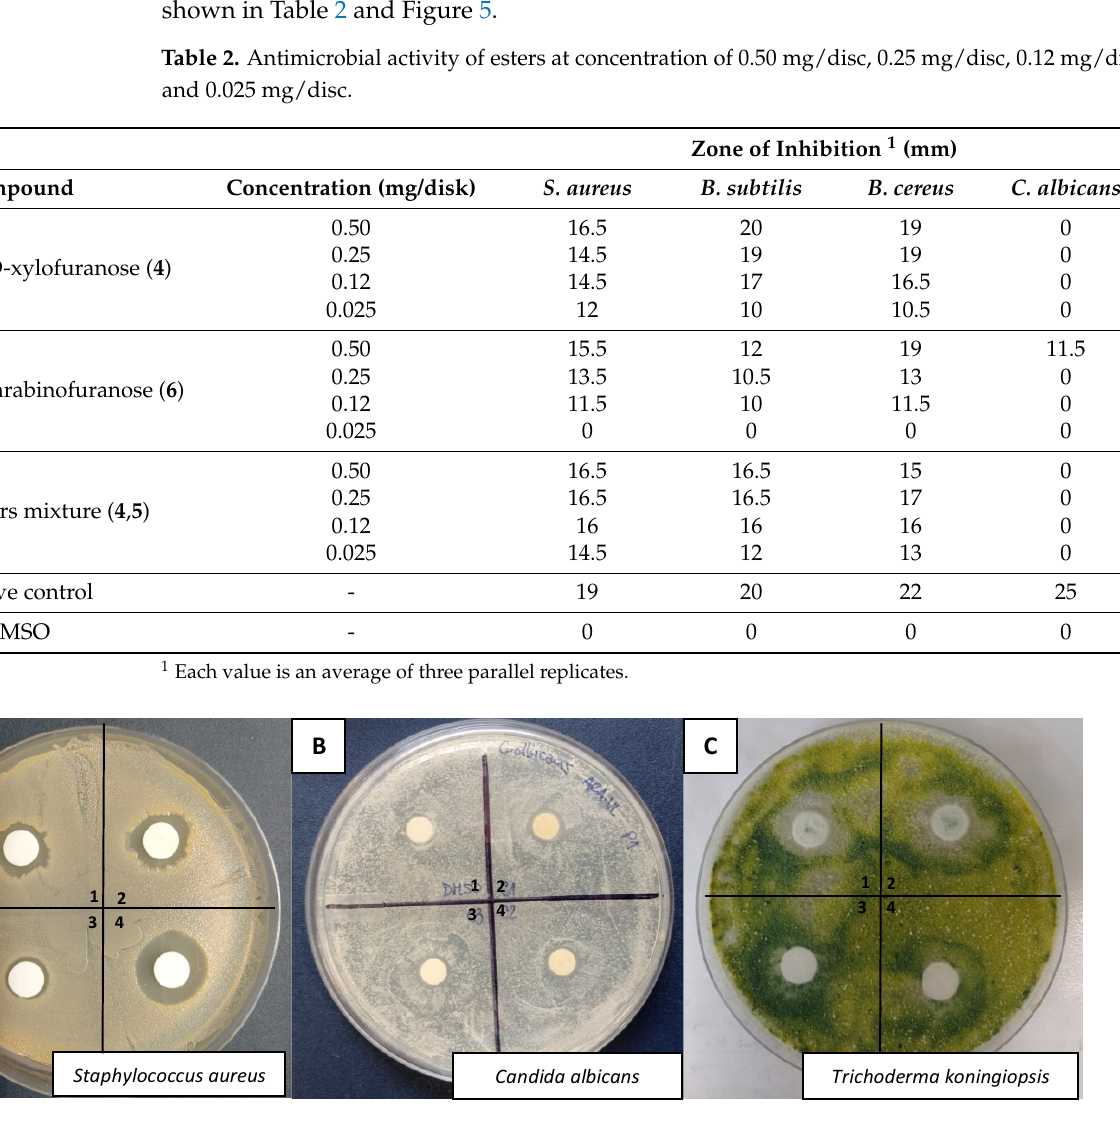
Figure 5. Antimicrobial tests results. ( A ) Inhibition zones obtained with 5-O-lauroyl- D -xylofuranose ( 4 ) at 0.25 mg/disc (quadrant 1), 0.12 mg/disc (quadrant 2), 0.025 mg/disc (quadrant 3), Gentamicin (positive control) (quadrant 4) against Staphylococcus aureus . ( B ) Inhibition zones obtained with 5- O -lauroyl- L -arabinofuranose ( 6 ) at 0.50 mg/disc (quadrants 3, 4), DMSO (quadrant 1) against Candida albicans . ( C ) Inhibition zones obtained with 5- O -lauroyl- L -arabinofuranose ( 6 ) at 0.50 mg/disc (quadrants 1 and 2), DMSO (quadrants 3, 4) against Trichoderma koningiopsis . The 5- O -lauroyl- D -xylofuranose, 5- O -lauroyl- L -arabinofuranose and the lauroyl es- ters mixture exhibited activity against Gram-positive bacteria and their inhibition zones diameters were similar to that of the antibiotic gentamicin (positive control). Both 5- O - lauroyl- D -xylofuranose and the lauroyl esters mixture showed antimicrobial activity at all the evaluated concentrations, whereas no action was observed in the case of 5- O -lauroyl- L - arabinofuranose at the minimum concentration (0.025 mg/disc) tested (Table 2). To the